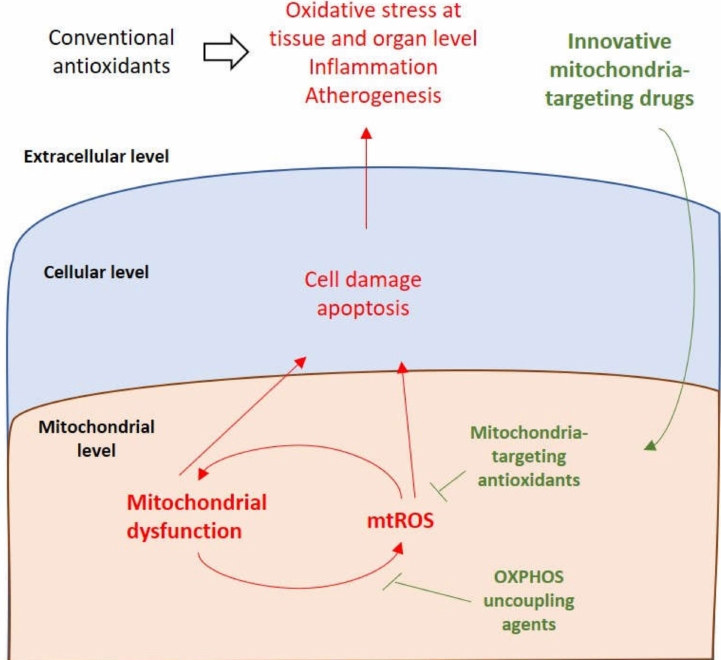
Figure 3. Mitochondria-targeting innovative therapies. While conventional antioxidants act at the organism level and often lack e ffi cacy, mitochondria-targeting agents penetrate the cell to accumulate in the mitochondria, where they can neutralize (T-bars) mitochondrial reactive oxygen species (mtROS) at the very beginning of the pathogenic cascade or block their production breaking the vicious circle of mitochondrial dysfunction